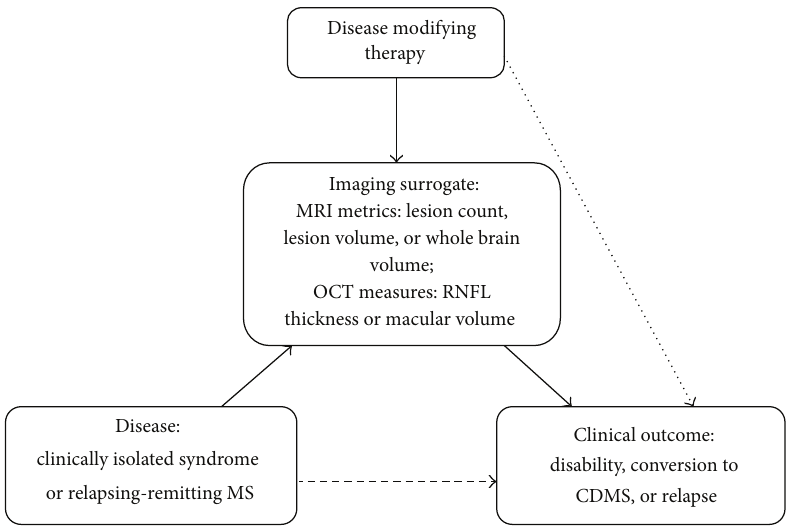
Figure 1: Clinical outcome measures and surrogate endpoints in Phase 3 clinical